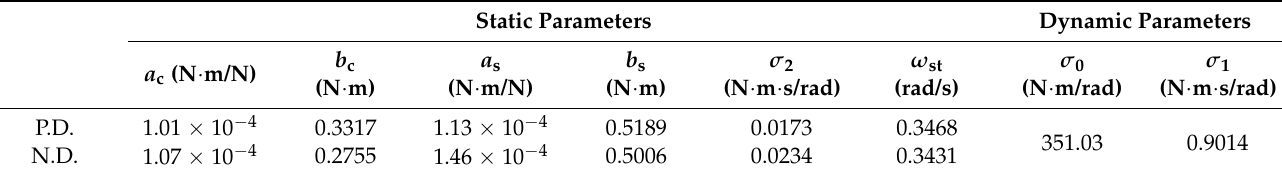
Table 1. Parameter identification results of the improved friction model. Static Parameters Dynamic Parameters